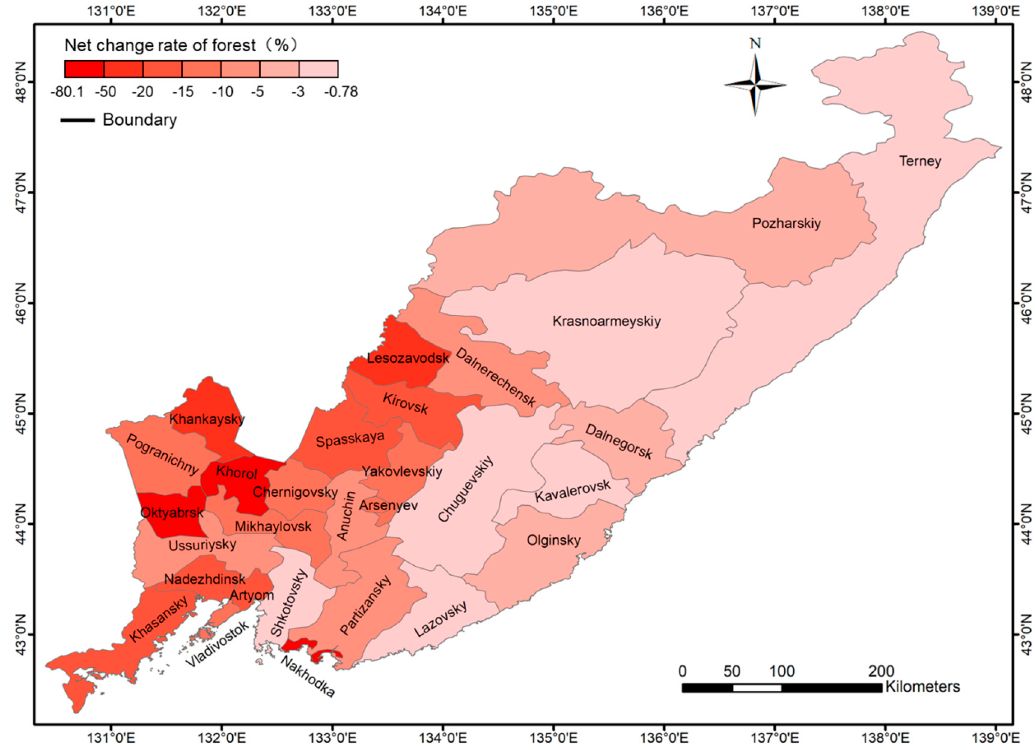
Figure 7. Net change rate of the forest area in the study area from 1998 to 2015. The forest area in each administrative district was reduced. In Oktyabrsk, Khorol, and Nakhodka City in the southwest of Sihot Alin, the reduction in forest area was the most severe.